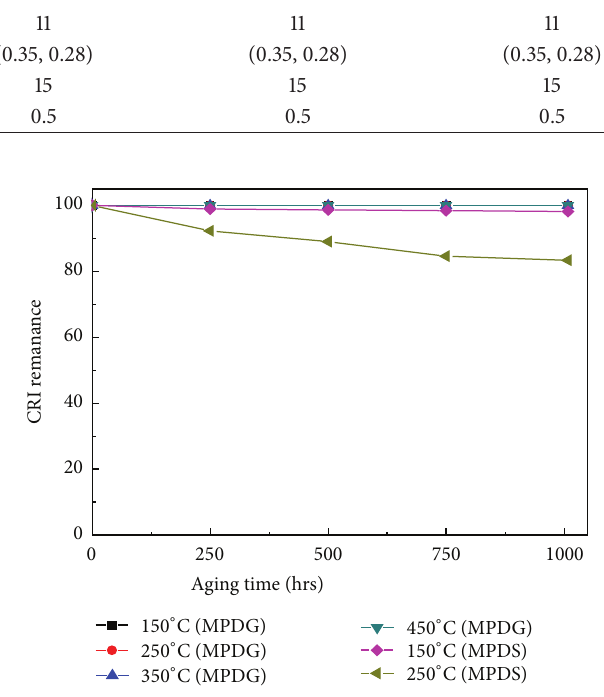
Figure 2: Quantum yield decay (%) versus aging time for PC- WLEDs of MPDG and MPDS samples at different temperatures.